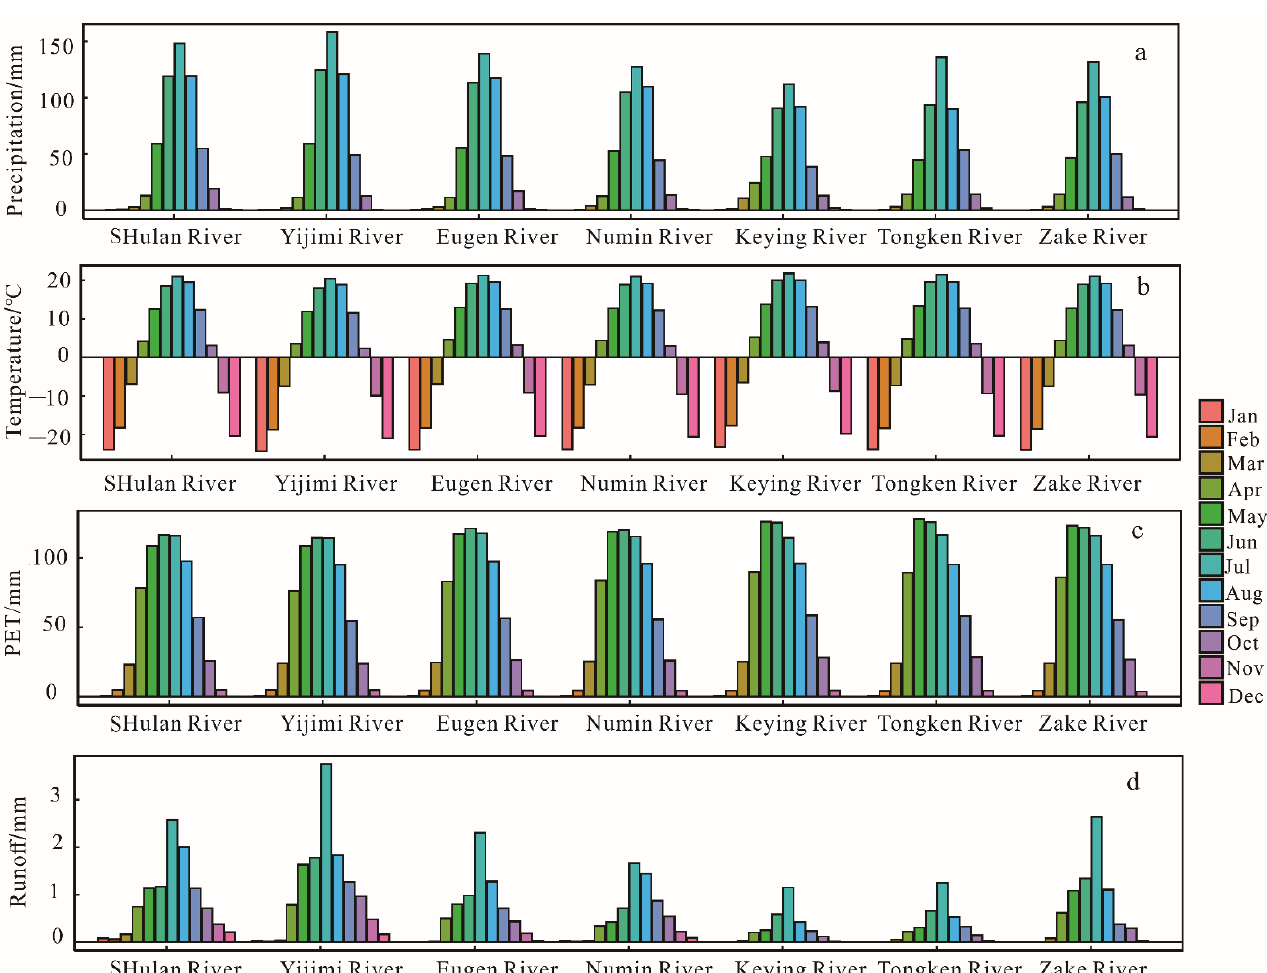
Figure 2. Monthly variation in precipitation, temperature, potential evapotranspiration, and runoff in the Hulan River Basin( a : monthly precipitation; b : monthly temperature; c : monthly potential evapotranspiration; d : monthly runoff).